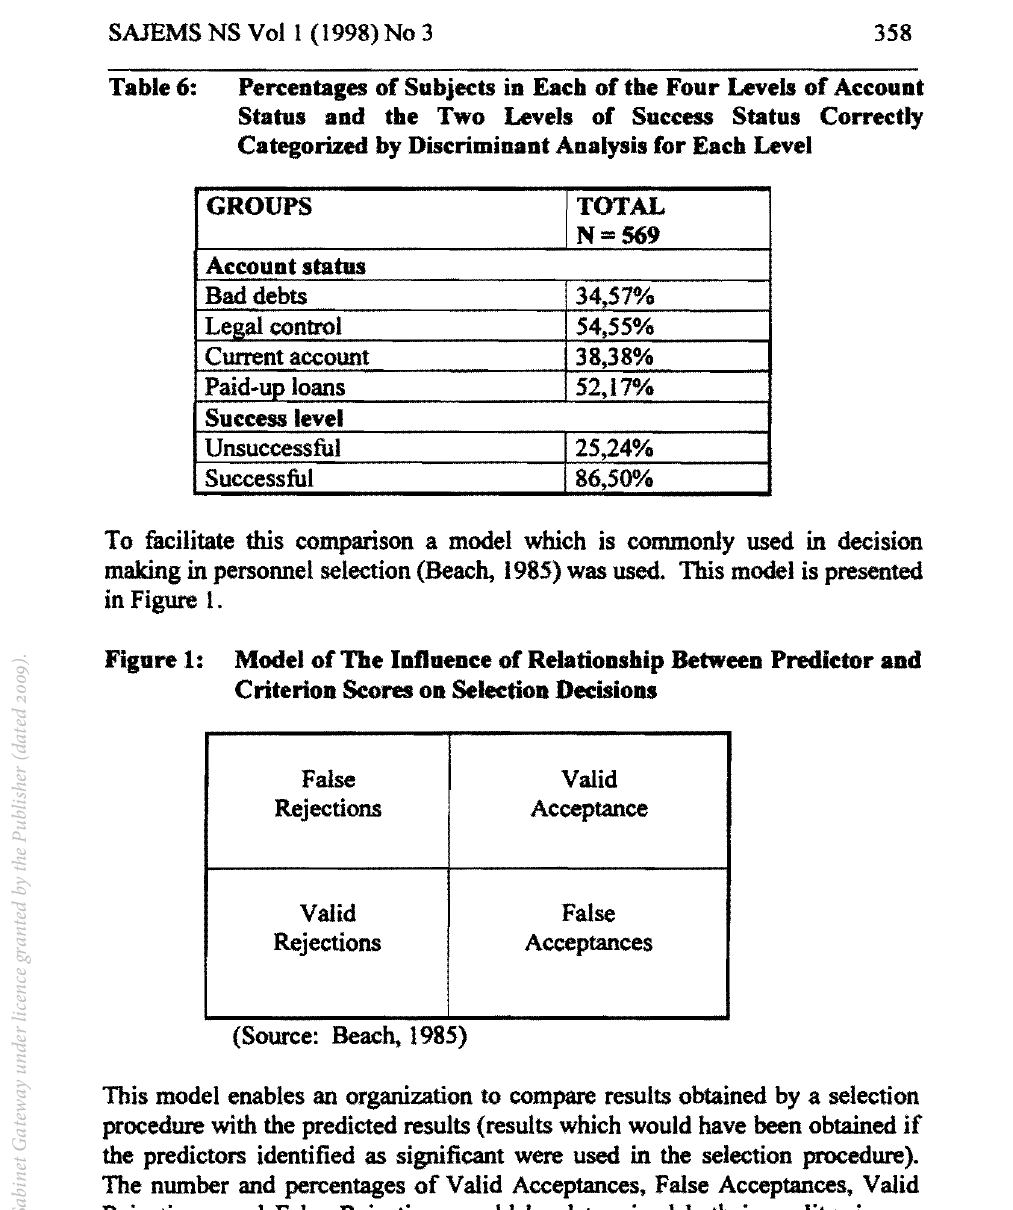
Percentages of Subjects in Each of the Four Levels of Account Status and the Two Levels of Success Status Correctly Categorized by Discriminant Analysis for Each Level